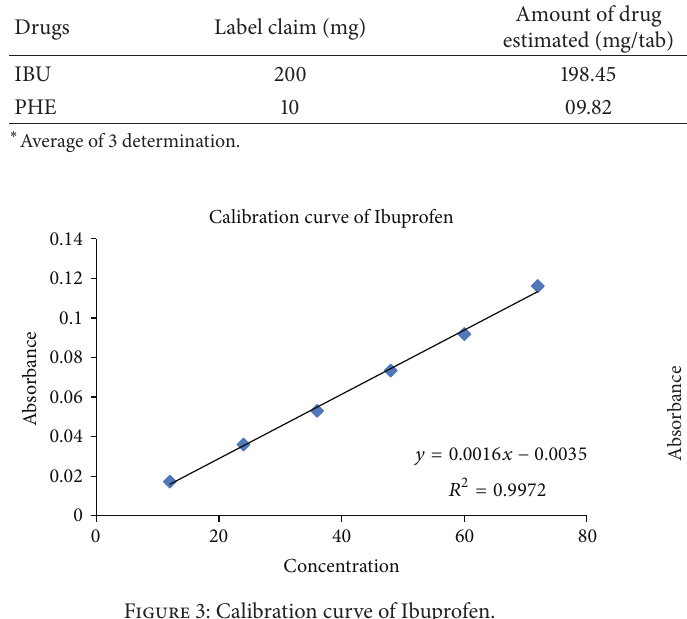
Figure 4: Calibration curve of Phenylephrine